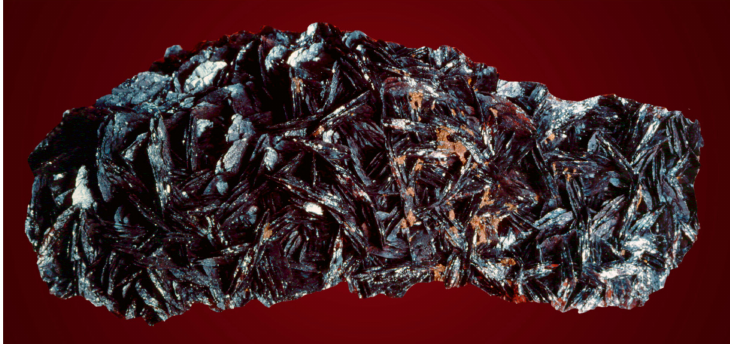
Figure 7. Hematite and goethite, Dodge mine. 10.9 cm. Chamberlain Collection, NYSM C5031. SC.